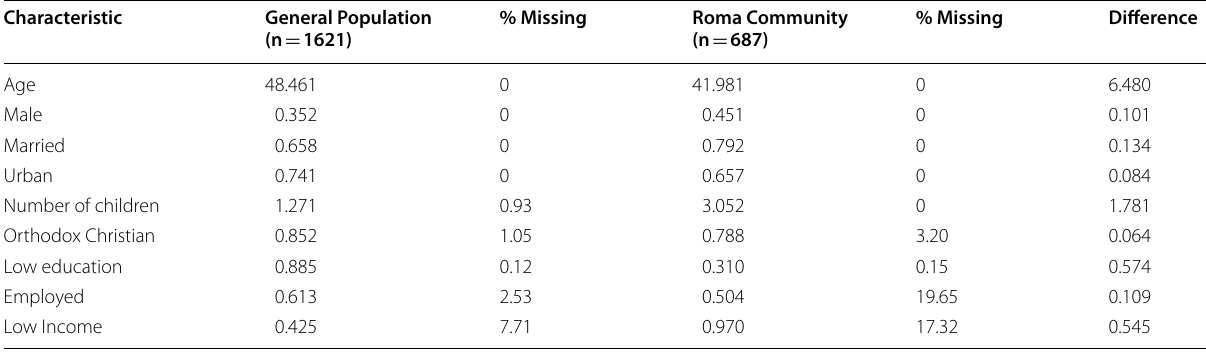
Table 4 Summary statistics for the main variables considered in the CEM procedure for the two samples and the percentage of missing values for each of them